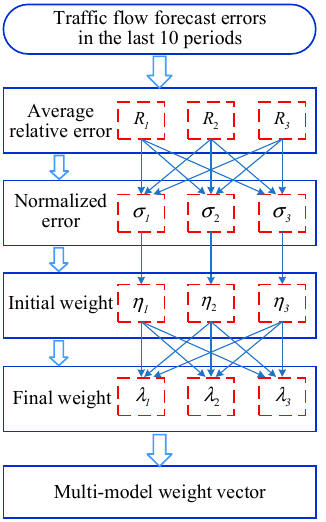
Figure 5. The calculation process of the multi-model weight vector.